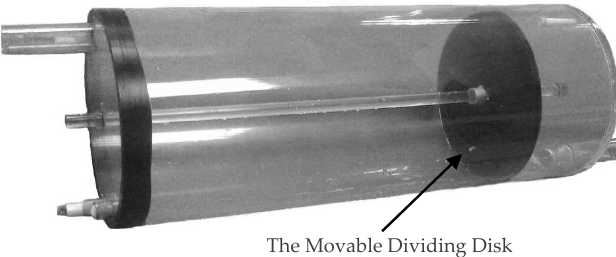
Figure 5. The physical model of the 3rd generation solar water heating tank.